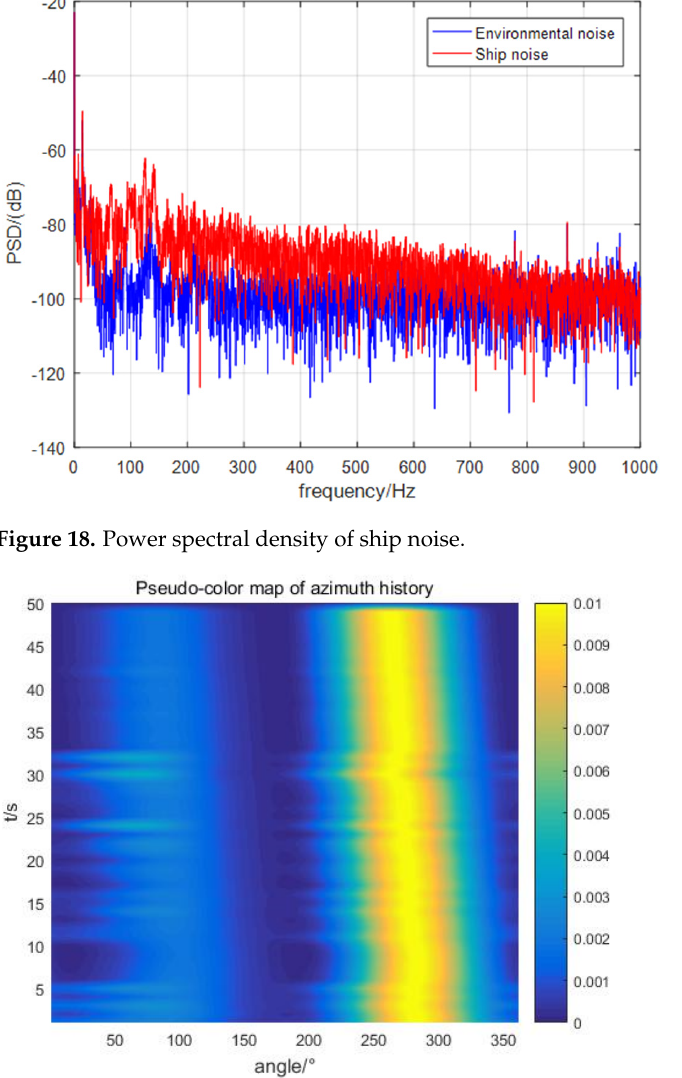
Figure 19. Waterfall diagram of ship target.